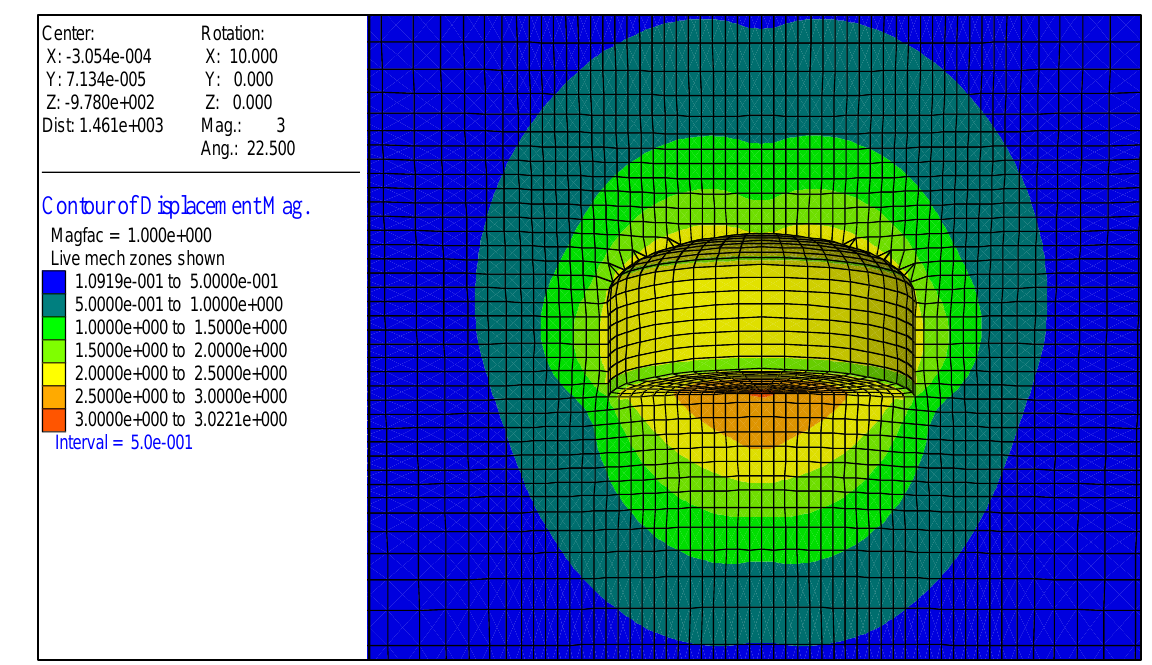
Figure 16. The contour of the displacement magnitude excavated in the rock salt chamber.